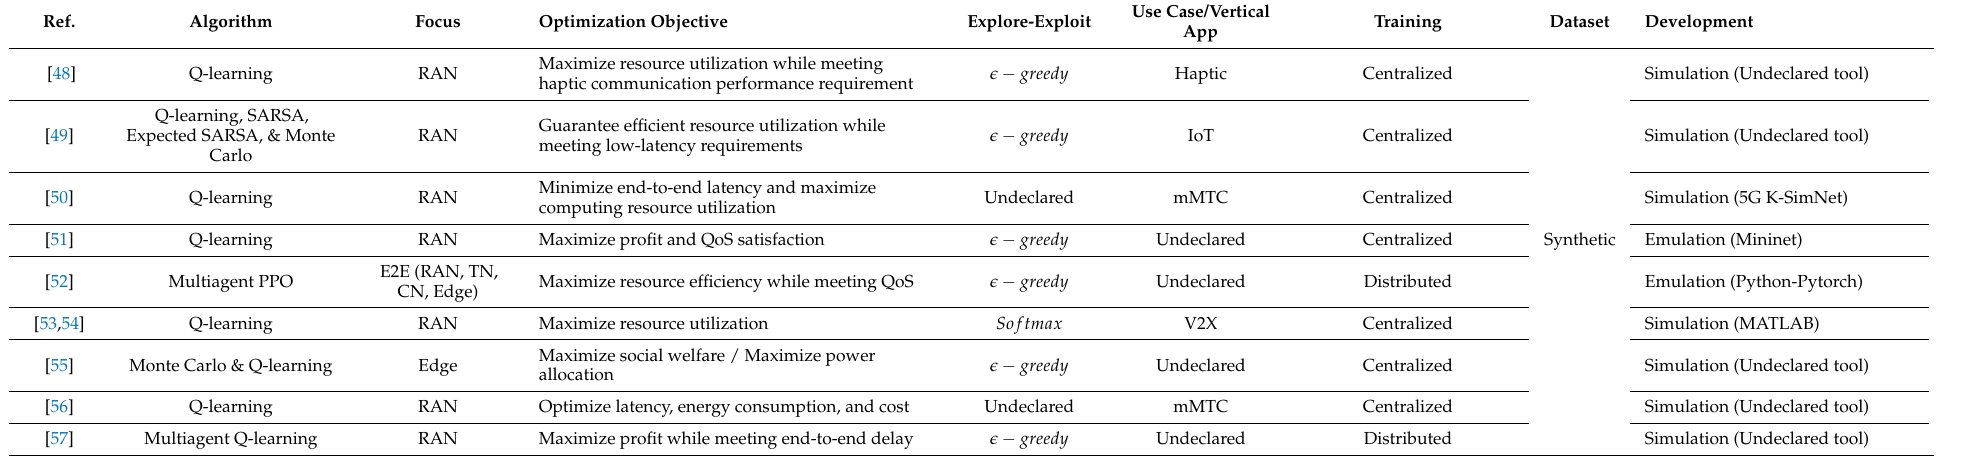
Table 2. Resource allocation based on